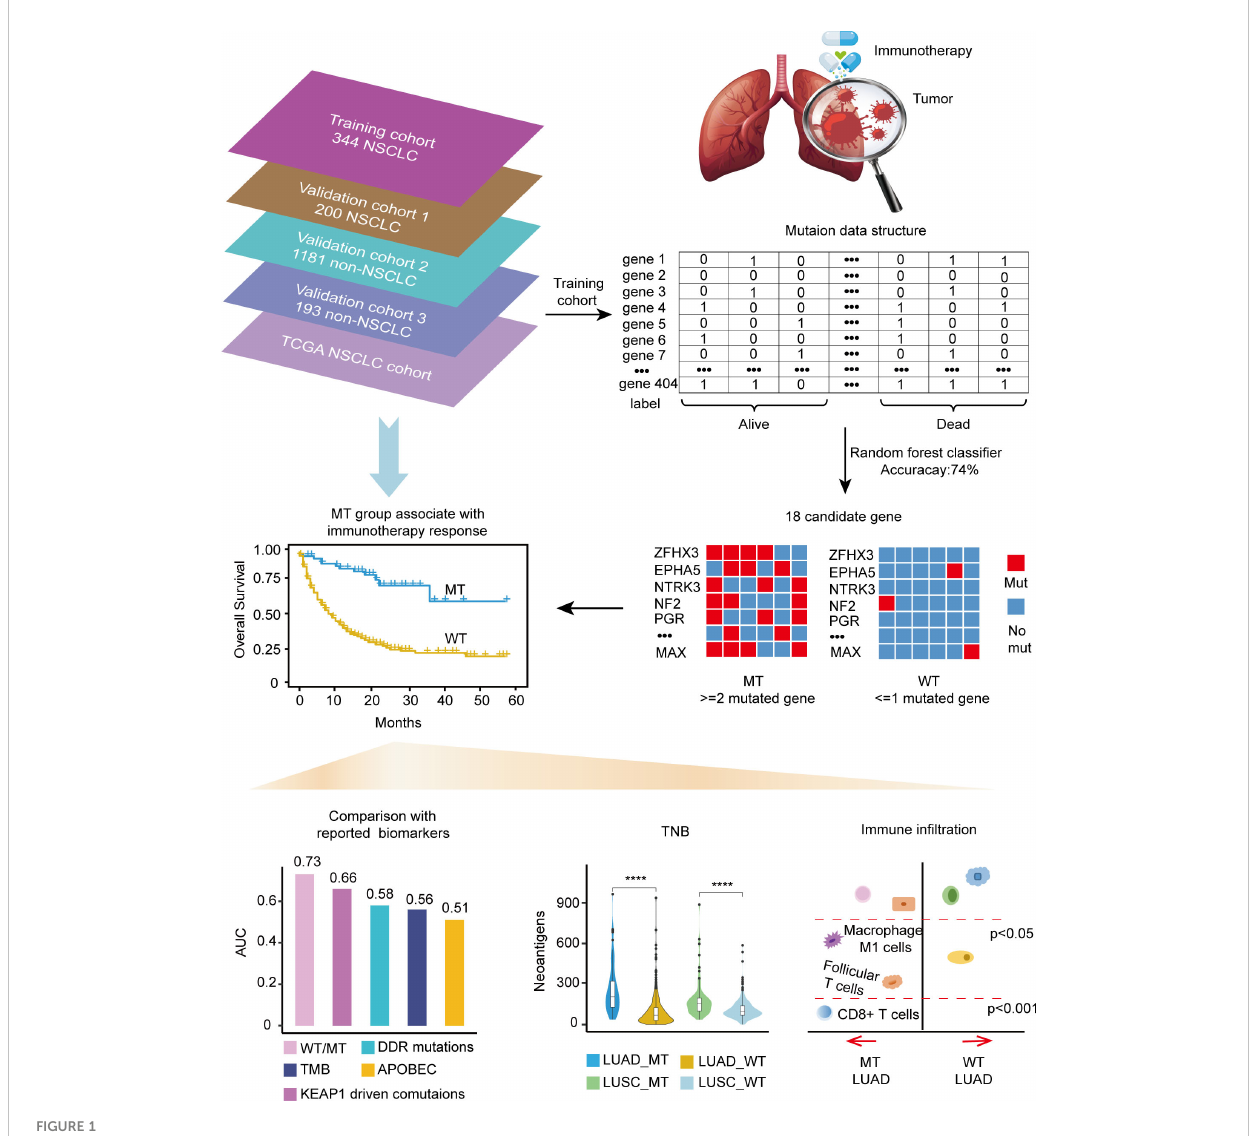
FIGURE 1 Work fl ow of the